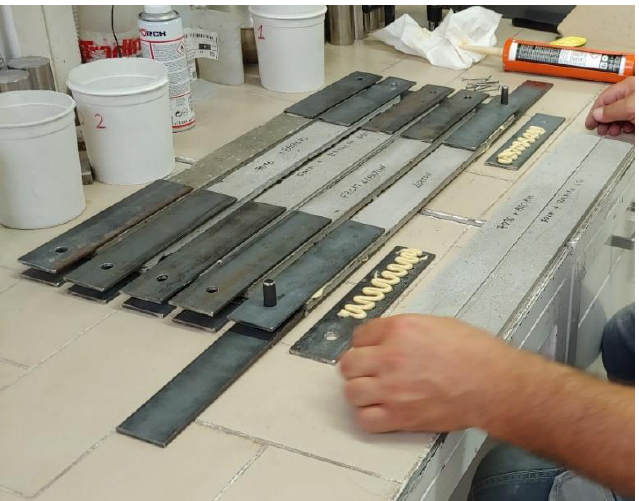
Figure 5. FRCM coupons at the hardened state with steel tabs bonded with epoxy